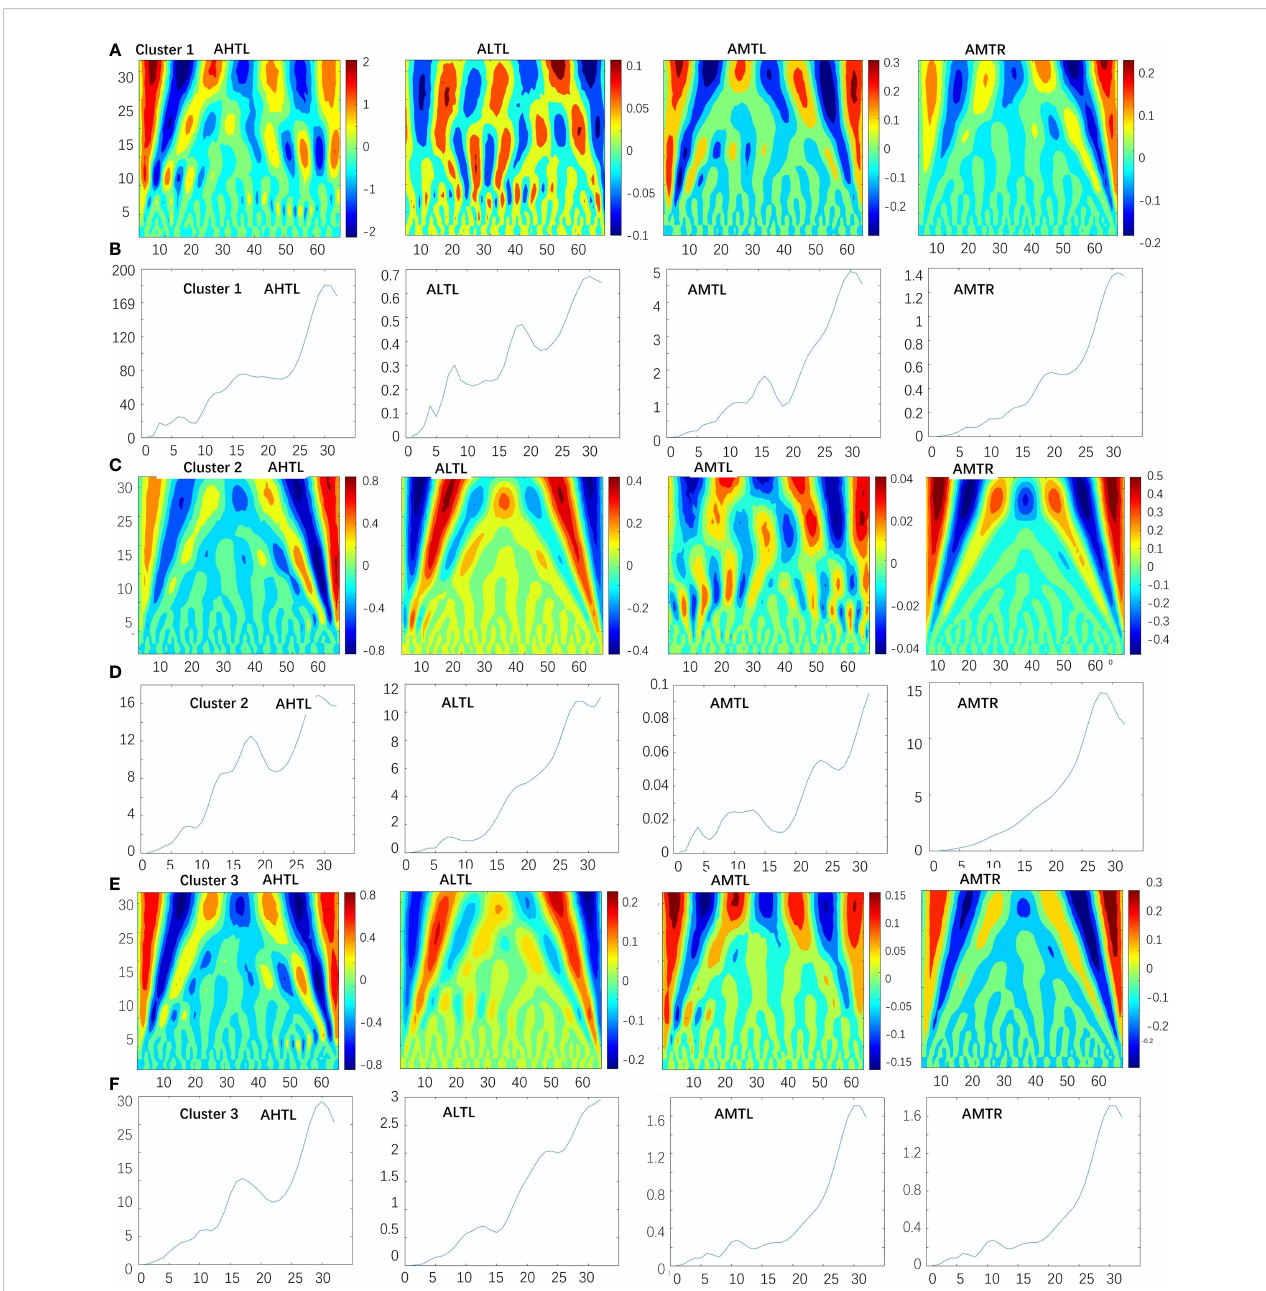
FIGURE 3 The local and global power wavelet spectrum of the tidal variables in PRE. (A, B) are the local and global power wavelet spectrum of AHTLs, ALTLs, AMTLs, and AMTRs in Cluster 1; (C, D) are the local and global power wavelet spectrum of AHTLs, ALTLs, AMTLs, and AMTRs in Cluster 2; (E, F) are the local and global power wavelet spectrum of AHTLs, ALTLs, AMTLs, and AMTRs in Cluster